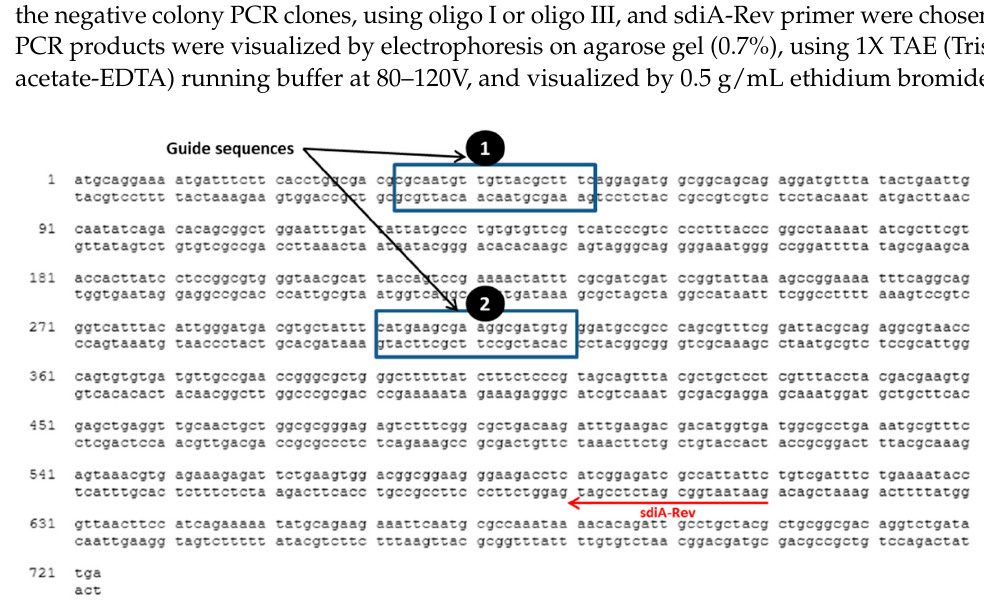
Figure 1. Guide sequences in S. enterica serovar Typhimurium NCTC 12023 sdiA gene (Gene ID, 1253471; NCBI Reference Sequence, NC_003197.2 (2039655..2040395). Oligo I and II were designed